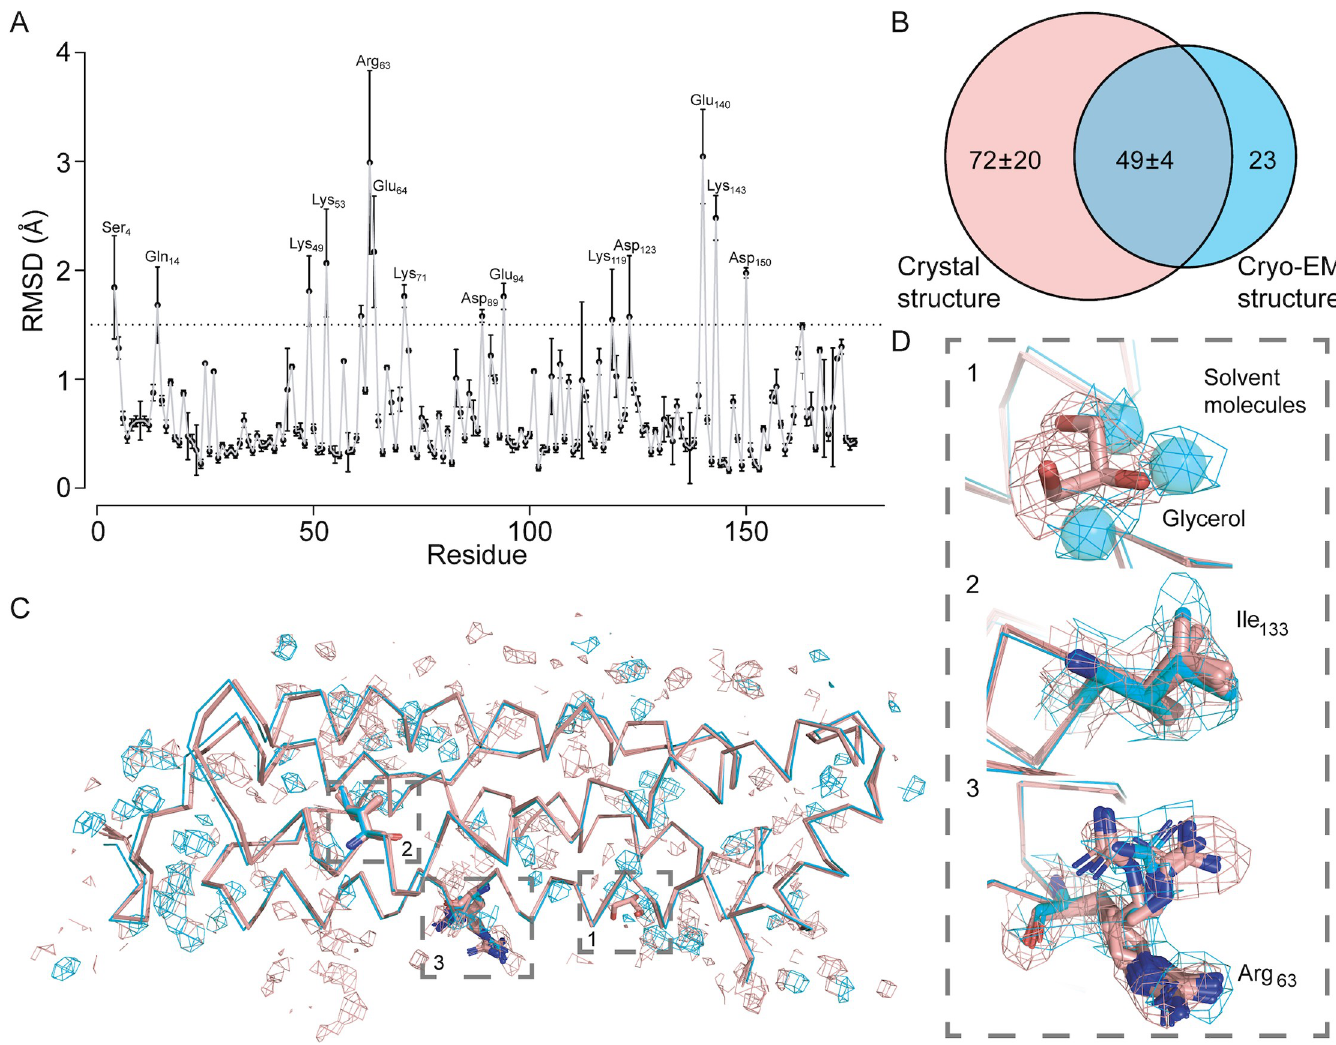
Fig 5. Comparison of the cryo-EM-derived structure to its crystallographic counterpart. Note that there are 12 monomers in the crystallographic asymmetric unit, so that comparisons are shown against all. (A) per-residue side-chain root-mean-square deviation (RMSD, Å ) for all atoms; backbone atoms show an overall RMSD of 0.395 Å . Residues exhibiting RMSD values > 1.5 Å are highlighted in the plot. (B) Venn diagram showing overlap of solvent molecules derived from the cryo-EM map with those of the crystallographic monomers. (C) overlay of C α atoms from the cryo-EM model (cyan) and the crystallographic monomers (pink) together with corresponding densities for the solvent. Boxes 1–3 denote positions shown in (D). (D) Comparison of cryo-EM (cyan) and X-ray (pink) models for selected residues with corresponding